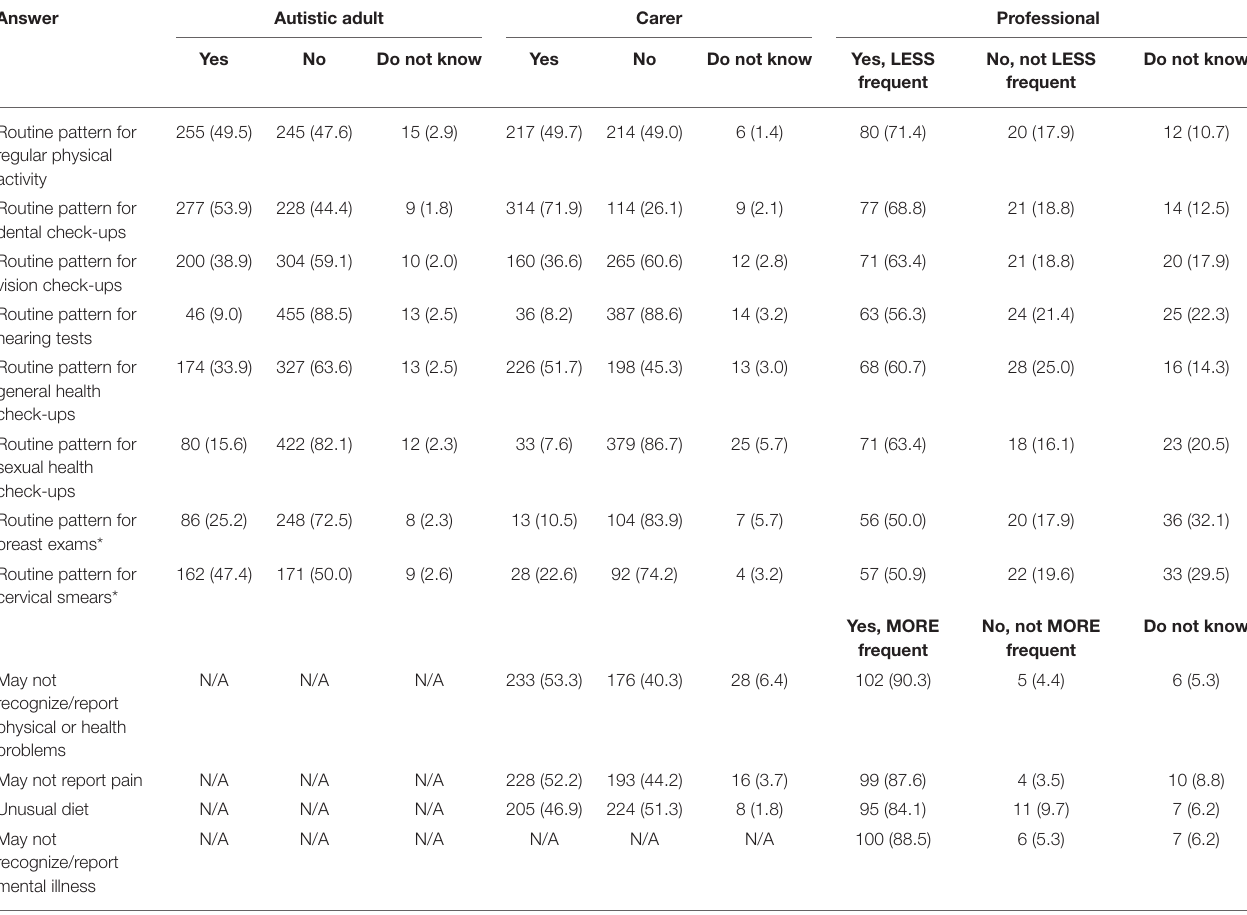
TABLE 3 | Health behavior profile of autistic adults. Answer Autistic adult Carer Professional